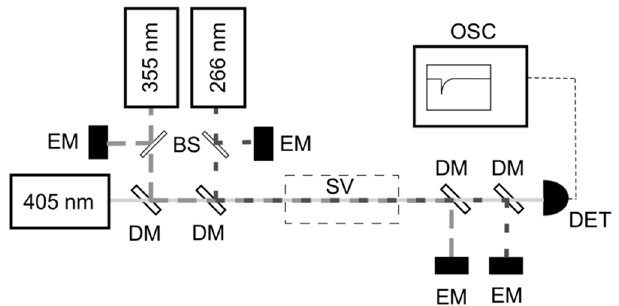
Figure 1. Experimental setup for the gas-phase detection of PbCl 2 . The transmission of the probe laser (405 nm) through a sample volume (SV) was monitored by a photodiode (DET) for collinear photofragmentation and atomic absorption spectroscopy (CPFAAS) signal upon double photofragmentation process of 355 nm and 266 nm laser pulses. Pulse energies were monitored by energy meters (EM) at the input and output. Beam splitters (BS) and dichroic mirrors (DM) were used to split, direct, and co-align the beams. An oscilloscope (OSC) was used for recording the signal for further analysis.